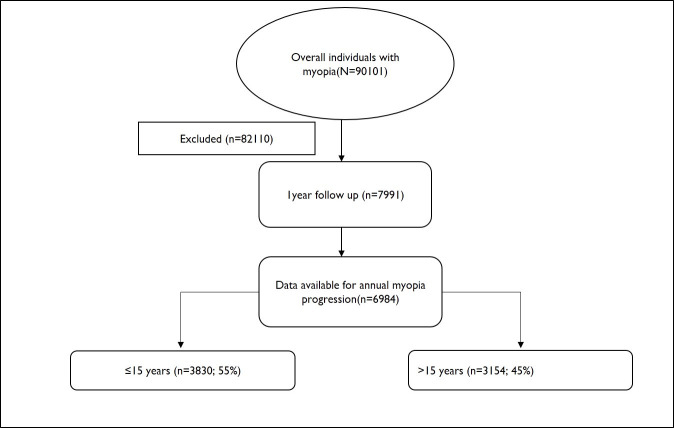
Flowchart with sample distribution based on inclusion and exclusion criteria.